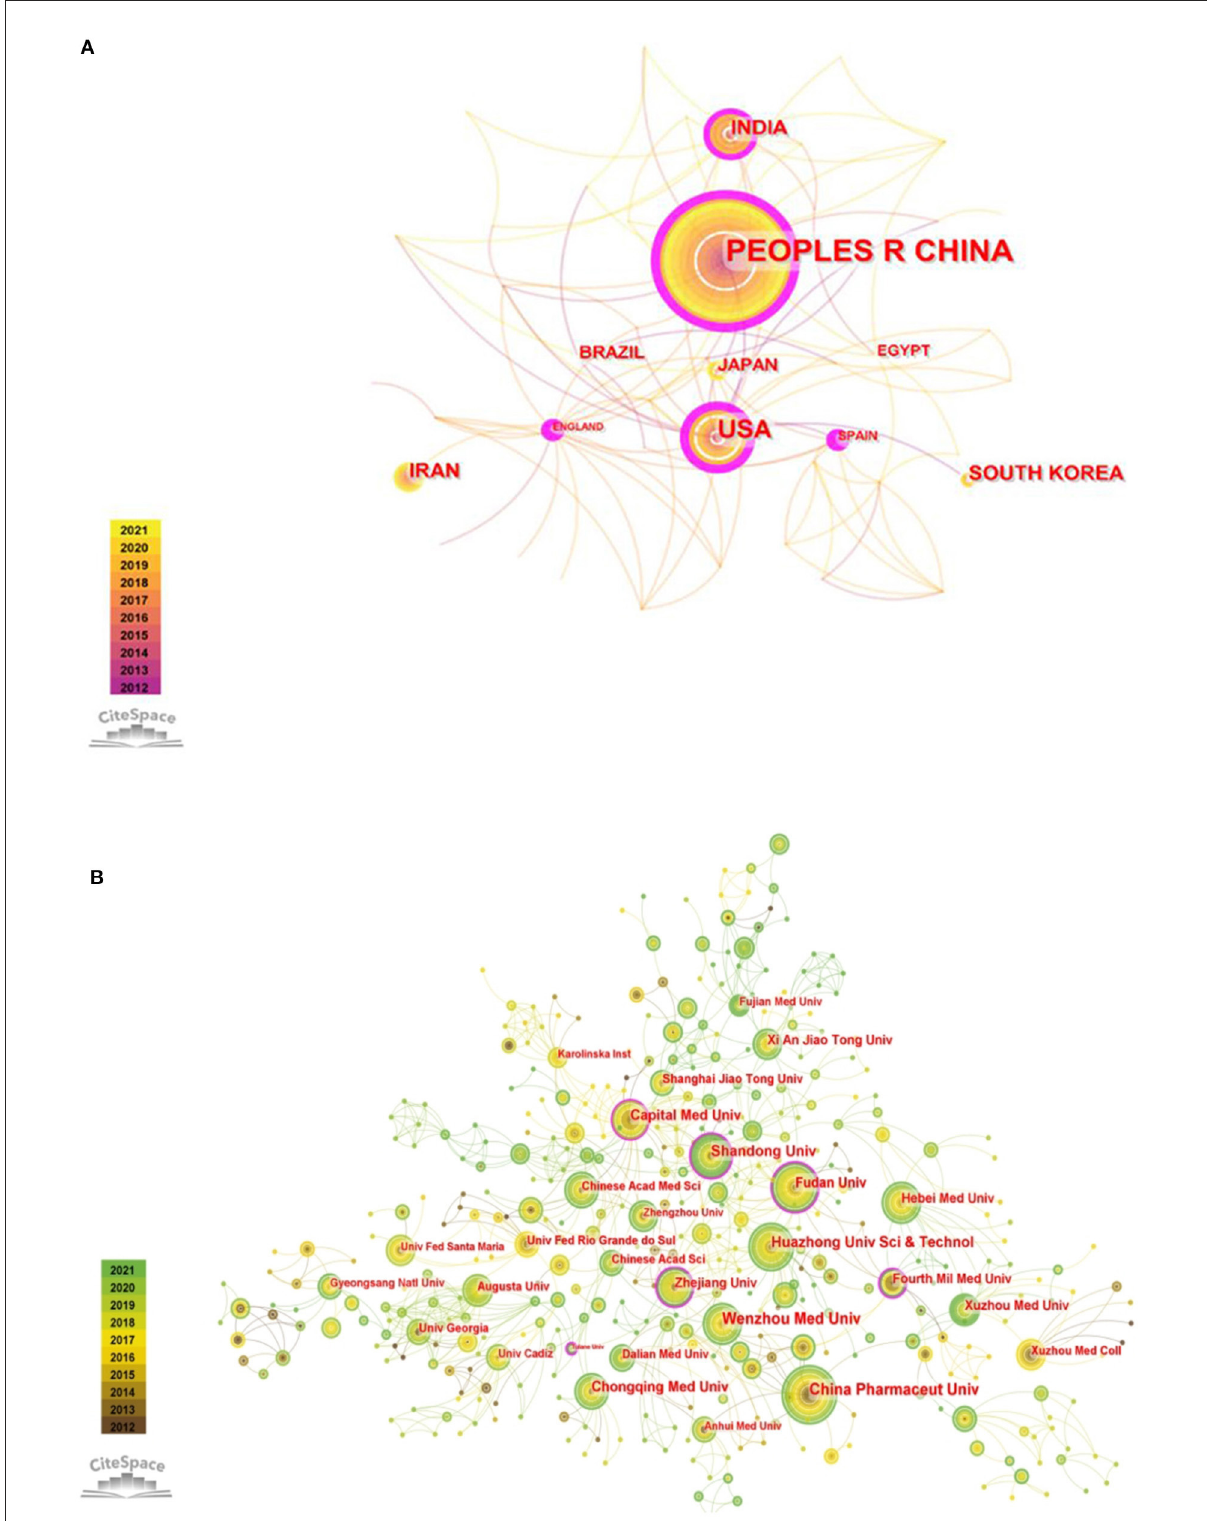
FIGURE2 (A) The network visualization of countries/regions collaboration. (B) The network visualization of institutions